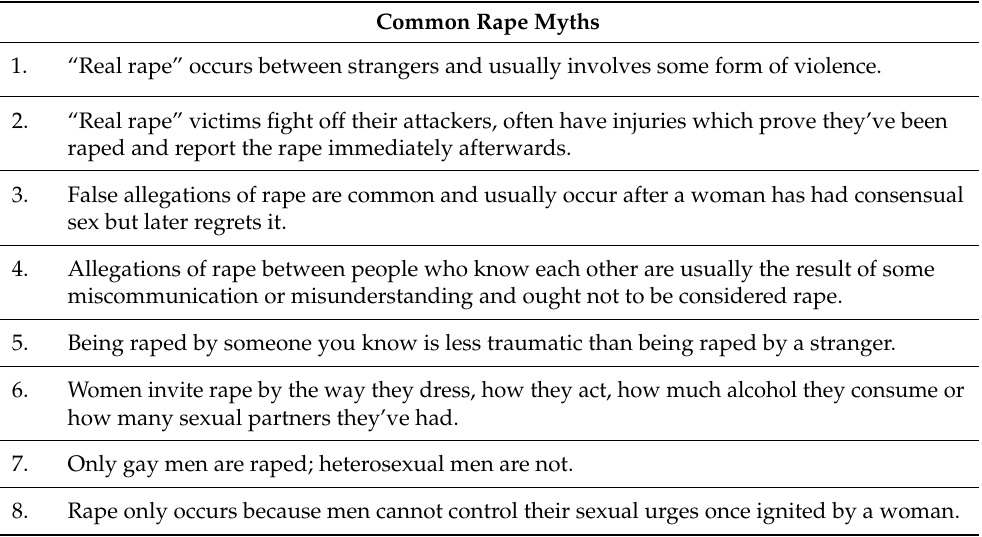
Table 1. Commonly Endorsed Rape